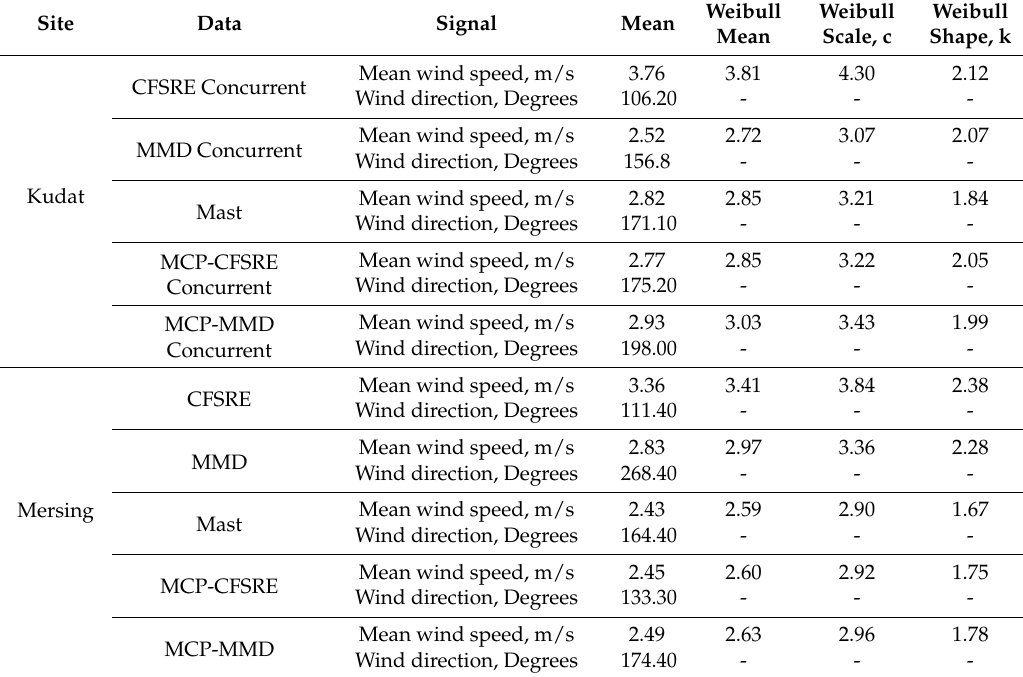
Figure 5. The comparison of the Weibull distribution function of wind mast data and four points of extended CFSR. Table 3. The mean wind speed and Weibull parameters of all data.